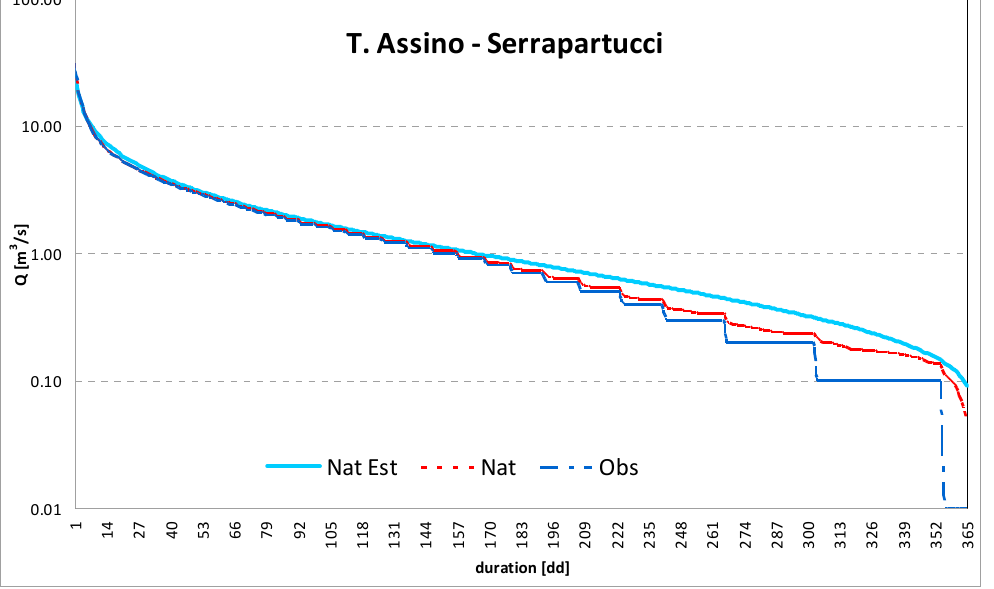
Figure 6. Average FDCs in the Migianella basin. Estimated natural FDC (Nat Est), natural FDC (Nat), and observed FDC (Obs). In the subsequent calculation of the WEI + index, little focus was put on the annual value but, rather, on the seasonal value and the peak month. Specifically, the seasonal value for the irrigation period (June–September) was considered significant, while the month of August was used for the monthly value.